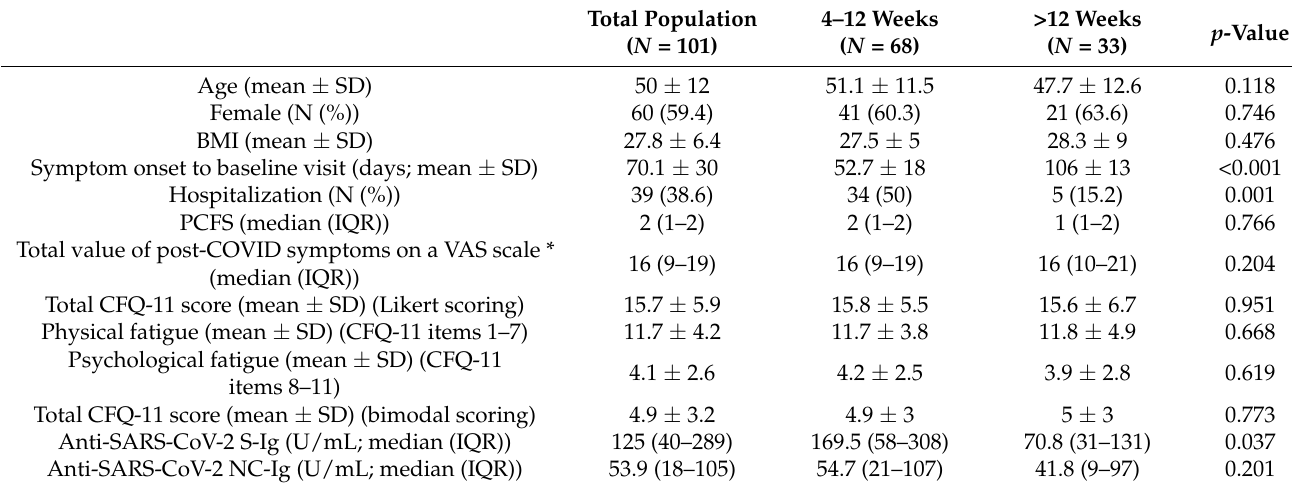
Table 1. Characteristics of the eligible patients with post-COVID symptoms according to time elapsed from first symptoms to date of baseline visit.